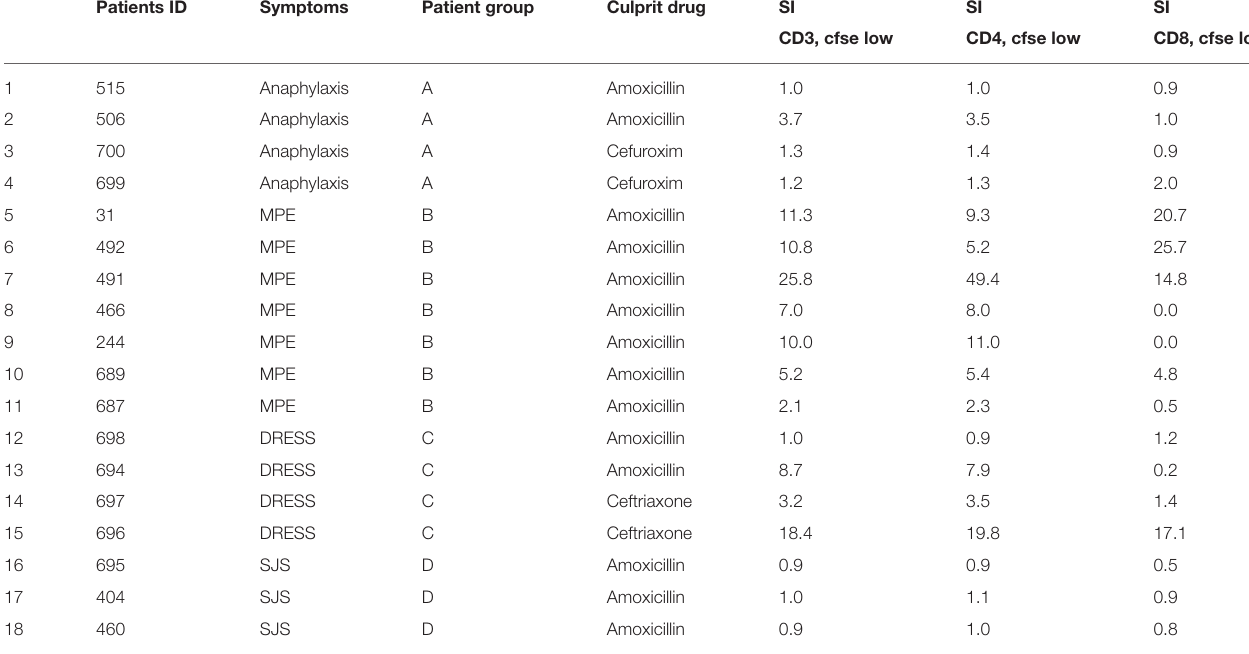
TABLE 1 | Summary of proliferation data to beta lactam antibiotics. Patients